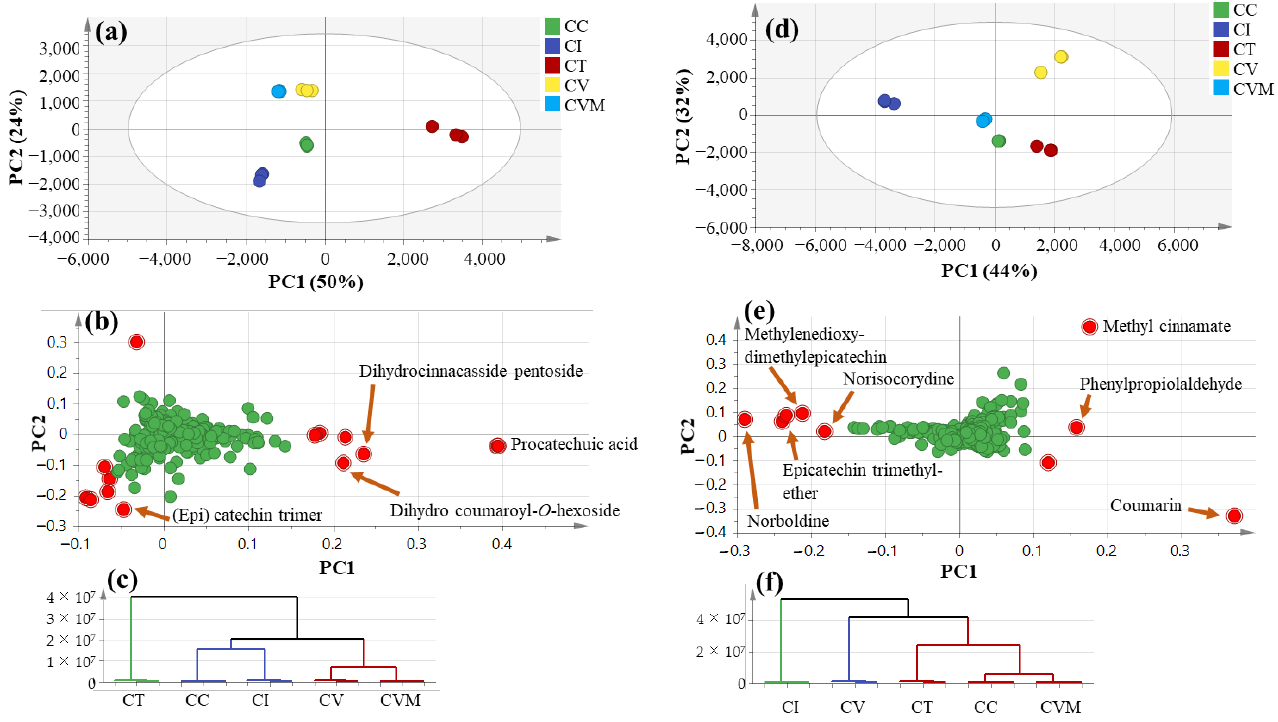
Figure 2. UPLC-MS principal component analyses of the different cinnamontaxa ( n = 3) on negative ion mode: ( a ) Score plot of PC1 vs. PC2, ( b ) respective loading plot with contributing mass peaks, ( c ) HCA and on positive ion mode, ( d ) Score plot of PC1 vs. PC2, ( e ) respective loading plot, ( f ) HCA. CC: Cinnamomum cassia from Malaysia, CI: C. iners from Malaysia, CT: C. tamala from Pakistan, CV: C. verum from Pakistan, CVM : C. verum from Malaysia.